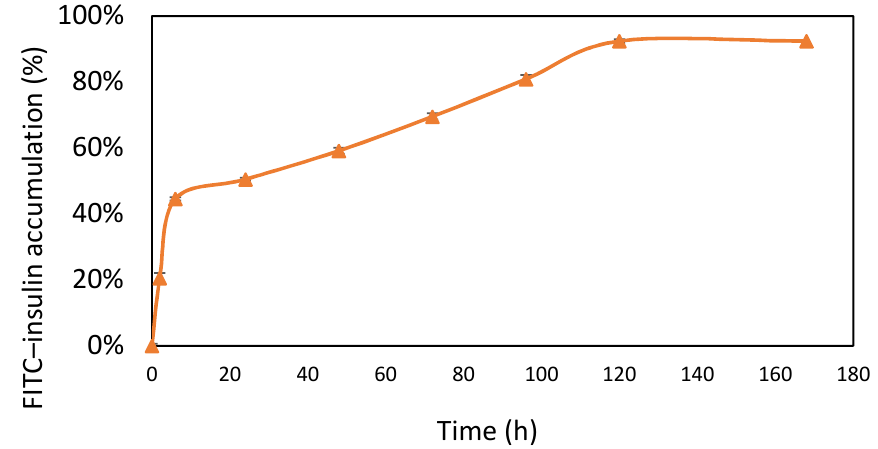
Figure 5. Insulin release profile ( n = 6). Data are expressed as means. Gel/HA–HAP–FITC–insulin had two stages of release. The release rate was faster in the first stage, which was caused by the insulin molecules on the surface of the composite. The release rate was slower in the second stage, which was attributed to degradation of the composite itself.